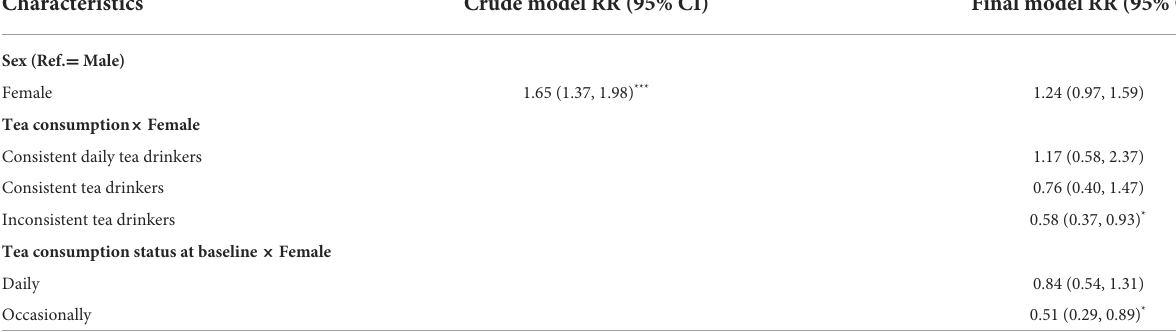
TABLE 4 Effect of interaction between tea consumption and sex on